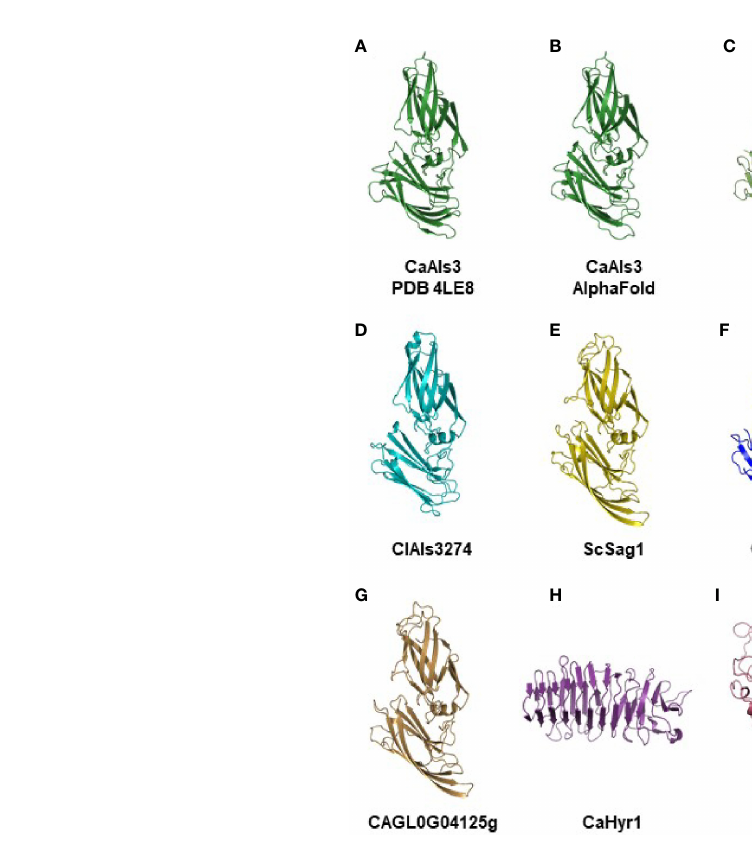
FIGURE 3 | Experimental and AlphaFold-predicted protein structures. (A) Crystallographic structure of C. albicans NT-Als3 (Protein Data Bank accession 4LE8) visualized using PyMOL. (B) C. albicans NT-Als3 structure predicted by AlphaFold from the 4LE8 amino acid sequence. AlphaFold structural predictions for the corresponding region of C. albicans NT-Als1 ( C ; 83% identical to NT-Als3), ClAls3274 ( D ; 33% identical to NT-Als3), ScSag1 ( E ; 25% identity), CauAls4498 ( F ; 31% identity), and CAGL0G04125g ( G ; 21% identity). An AlphaFold structural prediction was also completed for the N-terminal functional domain of C. albicans Hyr1 (H) and S. cerevisiae Flo1 (I) to demonstrate structural diversity among cell-surface proteins that contain a central domain of repeated sequences. The AlphaFold prediction for C. albicans NT-Als3 (B) recapitulated the known experimental structure ( A ; RMSD = 0.53 as calculated using PyMOL align). Predictions for molecules (B – G) produced the same general structure suggesting that all should be included in the Als protein family. Supplementary File S12 shows the structures of C. albicans NT-Als3 (B) and ScSag1 (E) aligned with the disul fi de bonds